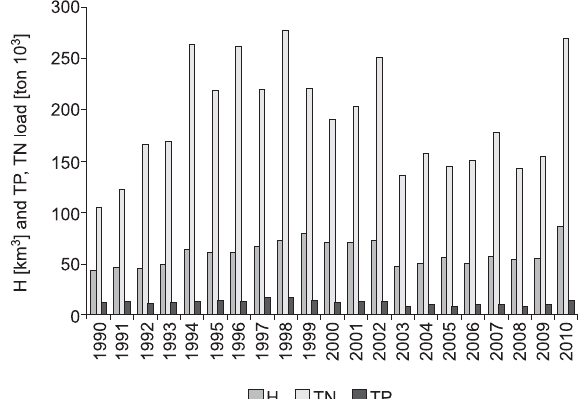
Fig. 1. River runoff and nutrients supplying Baltic Sea from Poland’s territory in the period 1990-2010, H – river run-off [km 3 ], TN – total nitrogen, and TP – total phosphorous